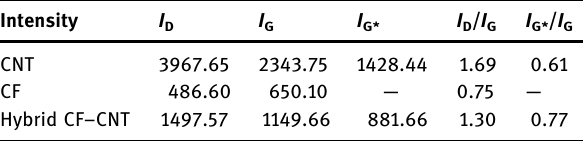
Table 2: Raman intensities of CNT, CF and hybrid CF –